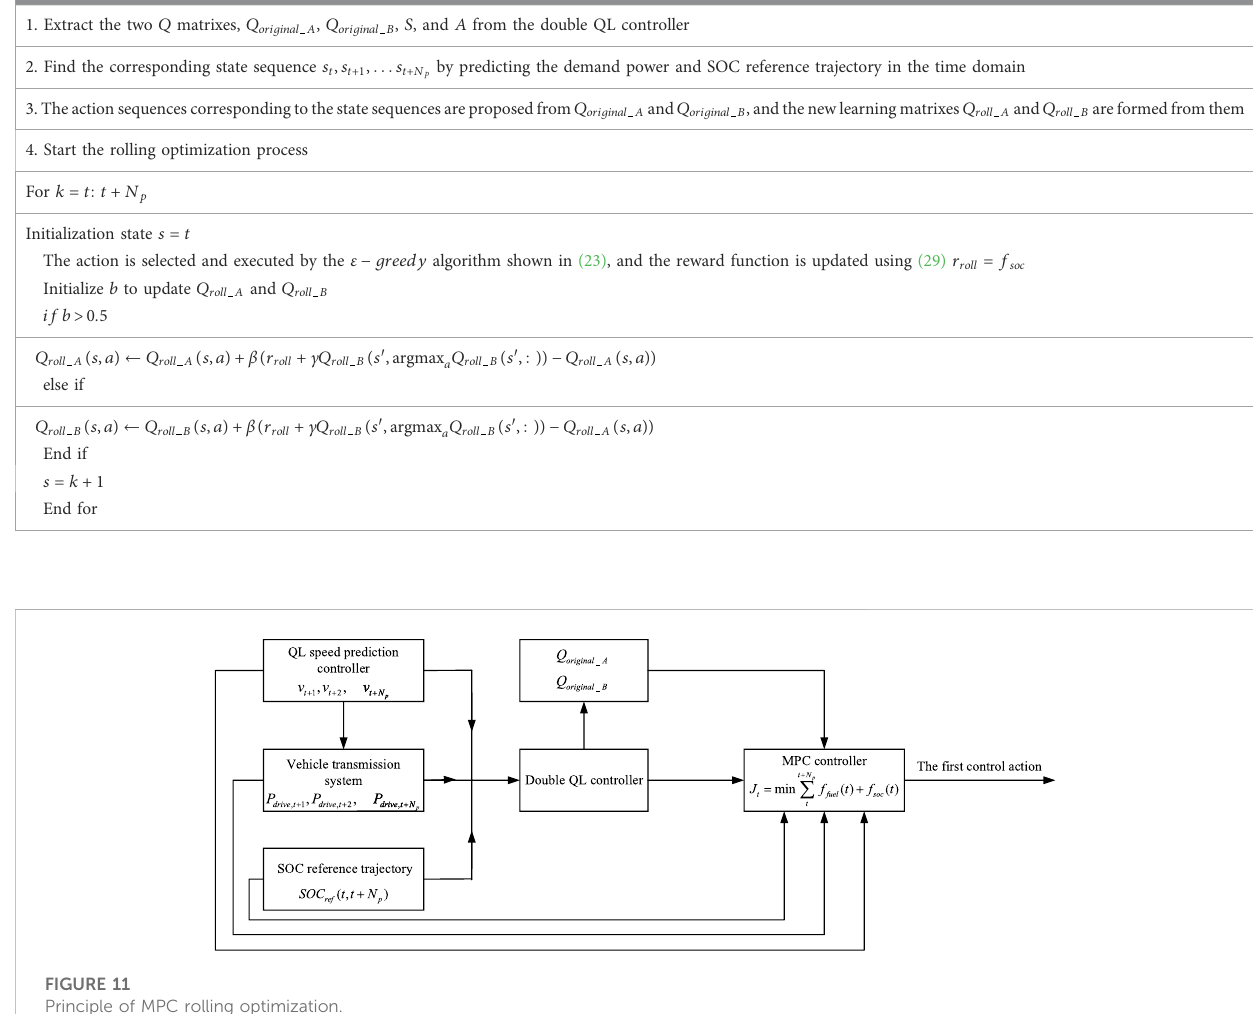
TABLE 4 Rolling optimization process. The rolling optimization process